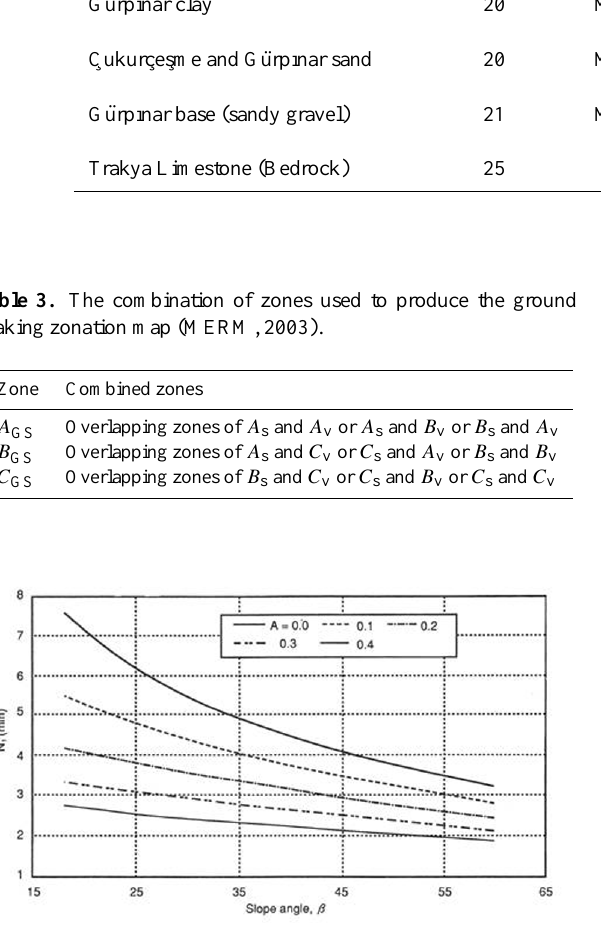
Fig. 9. Minimum N1 stability number change (Siyahi and Ansal,